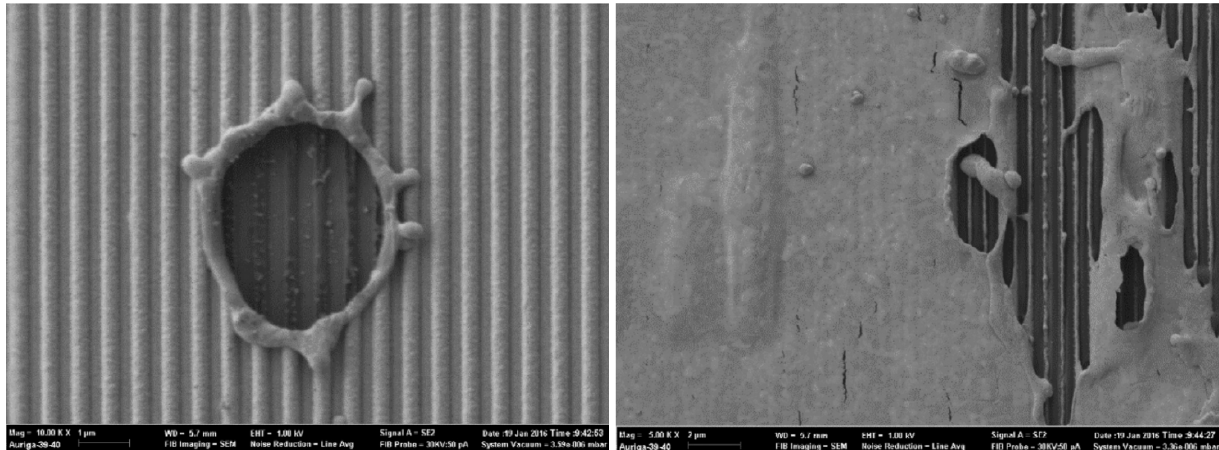
Figure 4. Damage morphology of the gold ‐ coated grating.